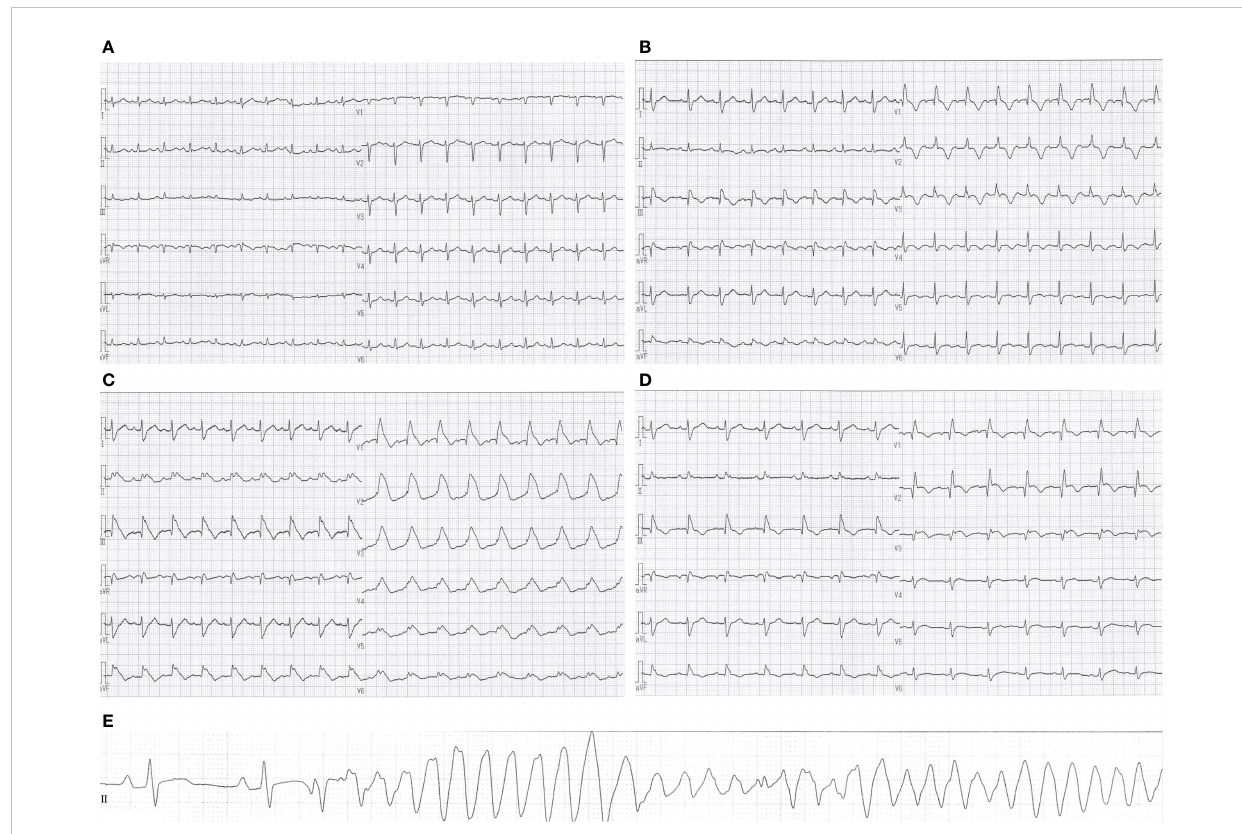
FIGURE 2 Changes in electrocardiographic waveforms during hospitalization. The admission electrocardiogram showed (A) sinus tachycardia and low-voltage QRS complexes. (B) Negative T waves appeared on electrocardiogram 27 days after admission, and (C) monomorphic VT appeared 5 days later. Eight days after the start of methylprednisolone administration, (D) negative T waves remained but ST-segment elevation was no longer present. Pre-death electrocardiogram showed (E) R-on-T phenomenon triggered polymorphic VT. QT/QTc intervals: (A) 313/443 ms, (B) 395/507 ms, (C) 433/572 ms, (D) 408/482 ms, (E) 400/408